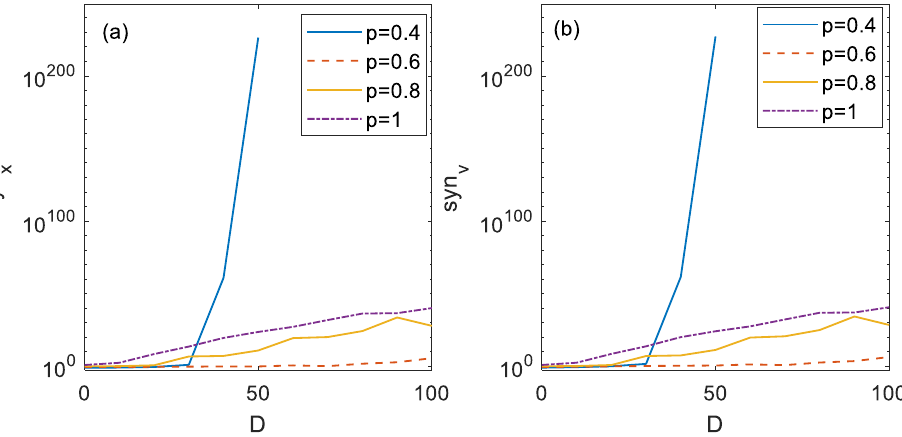
Figure 16. The average position/velocity synchronization error 𝑆𝑦𝑛 𝑥 ( a )/ 𝑆𝑦𝑛 𝑣 ( b ) curves of noise intensity D of FOMAS (2) with different fractional-orders 𝑝 (unbounded Gaussian noise).